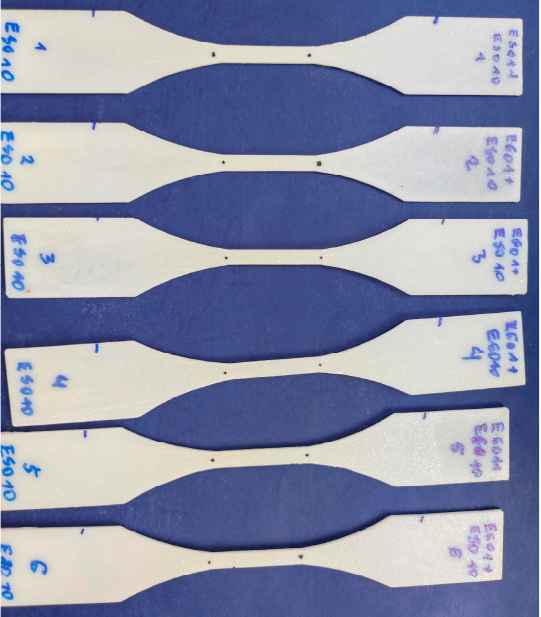
Figure 4. Exemplary set of test specimens prepared for testing that are made of epoxy resin E601 with the addition of ESO10.